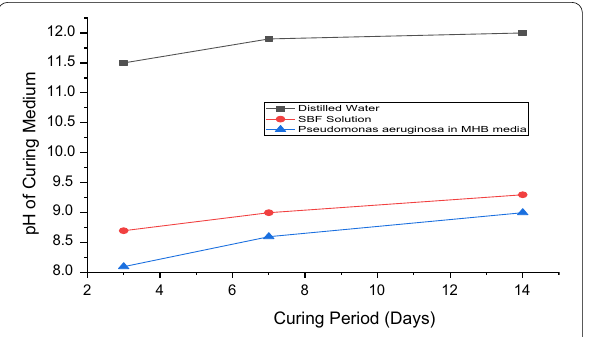
Fig. 4 pH values of distilled water (DW), simulated body fluid (SBF) and Pseudomonas aeruginosa in Mueller Hinton Broth (MHB media)